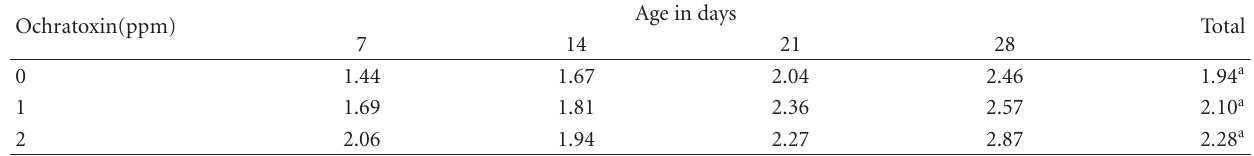
Table 3: Feed conversion (feed/gain) in broiler chicken fed ochratoxin.